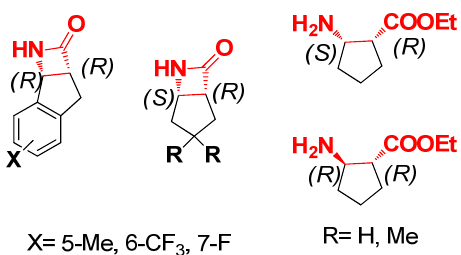
Figure 2. β -lactams and β -amino